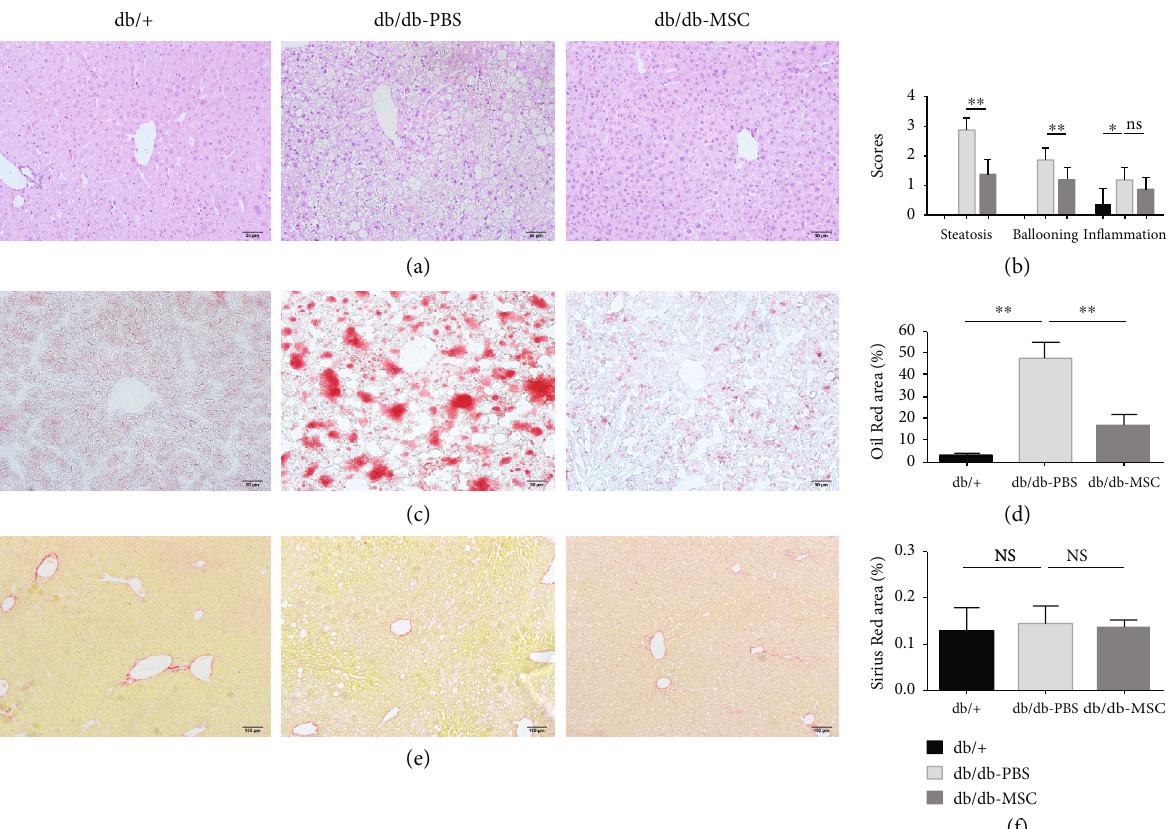
Figure 4: Human UC-MSC infusions ameliorated hepatic steatosis. (a) Representative images of HE-stained liver sections of the indicated groups. Scale bar = 50 μ m . (b) Steatosis, ballooning, and in fl ammation in the liver of the indicated groups were scored. (c) Representative images of Oil Red O-stained liver sections of the indicated groups. Scale bar = 50 μ m . (e) Representative images of Sirius Red-stained liver sections of the indicated groups, scalebar = 100 μ m . Quantitative analysis of (d) the Oil Red O-positive area and (f) the Sirius Red-positive area in the respective groups. n = 5 sections per group. All data are represented as means ± SD . ∗ p < 0 : 05 ; ∗∗ p < 0 : 01 . ns: not signi fi